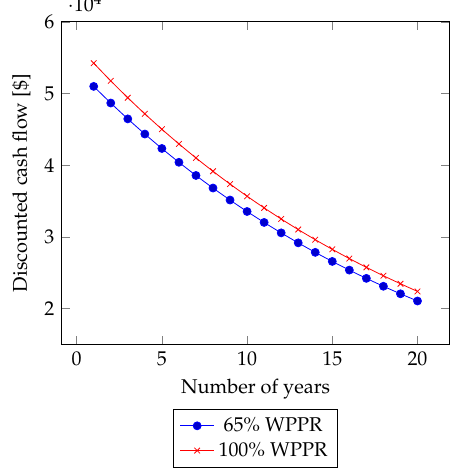
Figure 5. Influence of WPPR on discounted cash